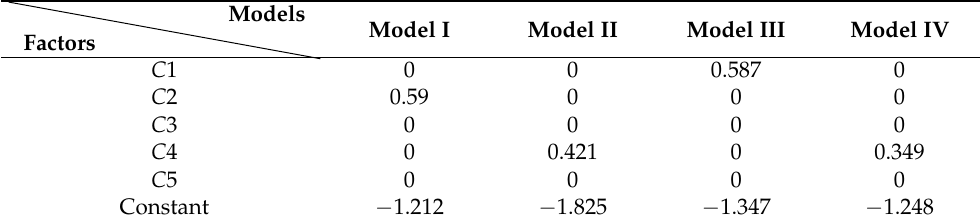
Table 11. The regression coefficients of common factors in LR